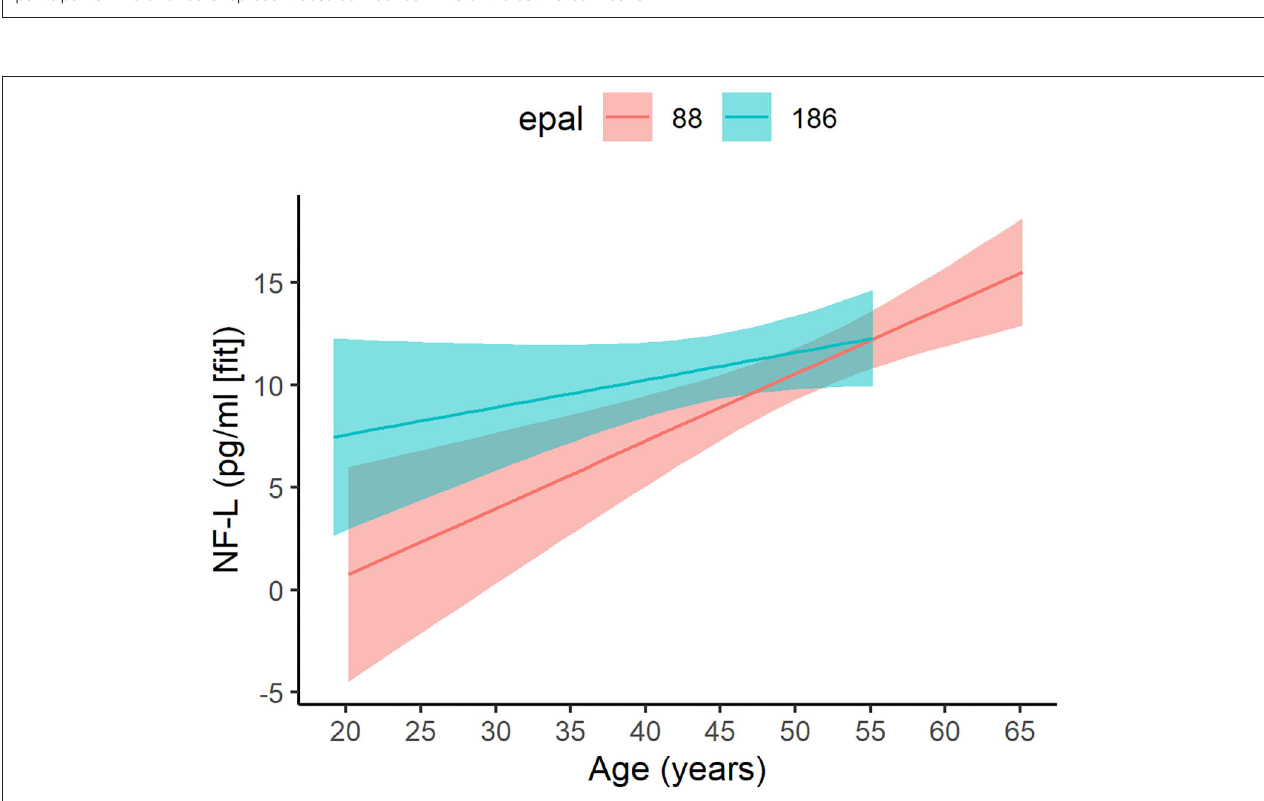
FIGURE 3 | Age-related change in patients with varying ePAL. Age-related change ( x -axis) of ePAL ( y -axis) differed for patients with higher repeats (blue) relative to those with lower repeats (pink). To effectively depict the interaction, two representative ePAL repeats were selected based on the median split. The regression lines and confidence limits were derived from a mixed linear model that included random intercepts and slopes for age at evaluation, as well as a random effect for participants. Predictions for the observed age range are included only.